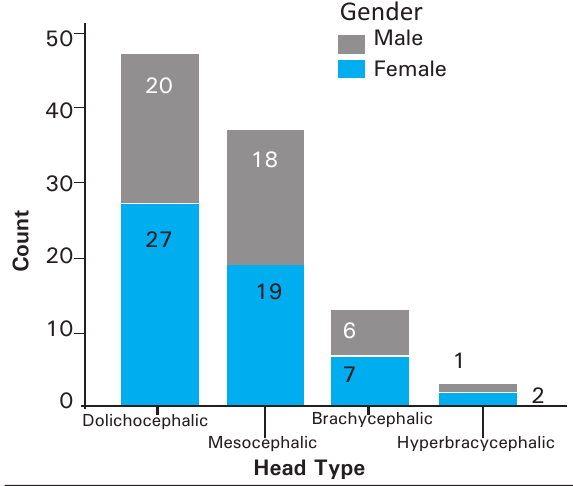
Figure 1. Bar-diagram showing distribution of head types.